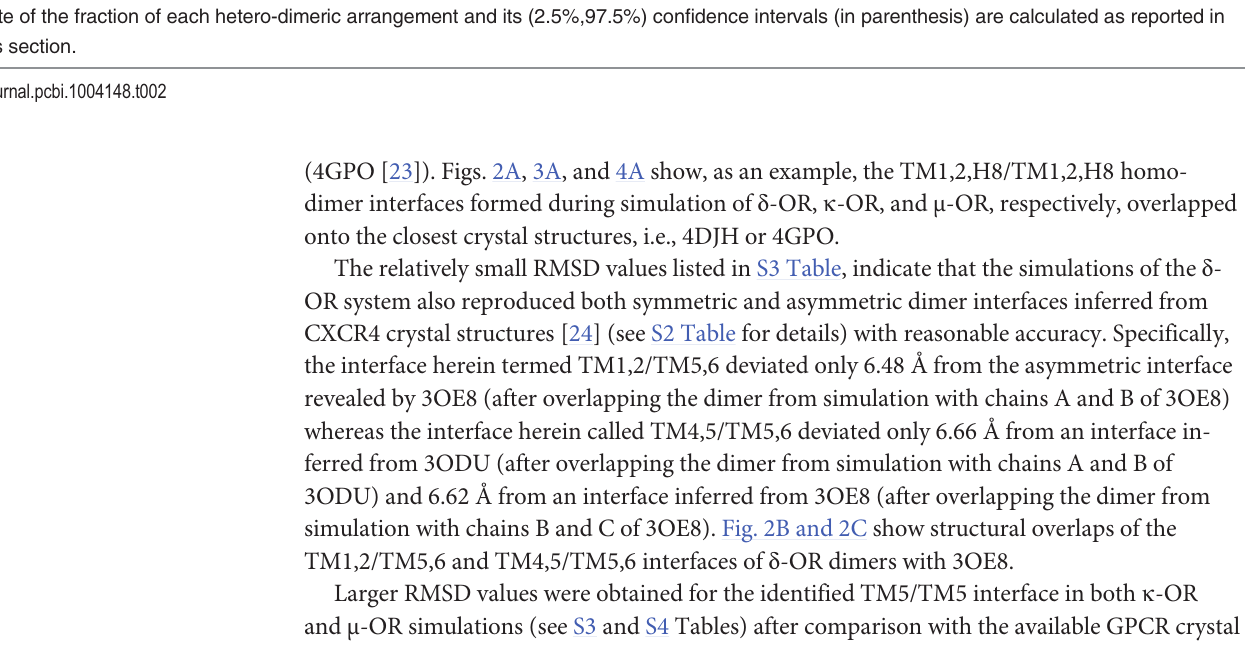
Best estimate of the fraction of each hetero-dimeric arrangement and its (2.5%,97.5%) con fi dence intervals (in parenthesis) are calculated as reported in the Methods section.